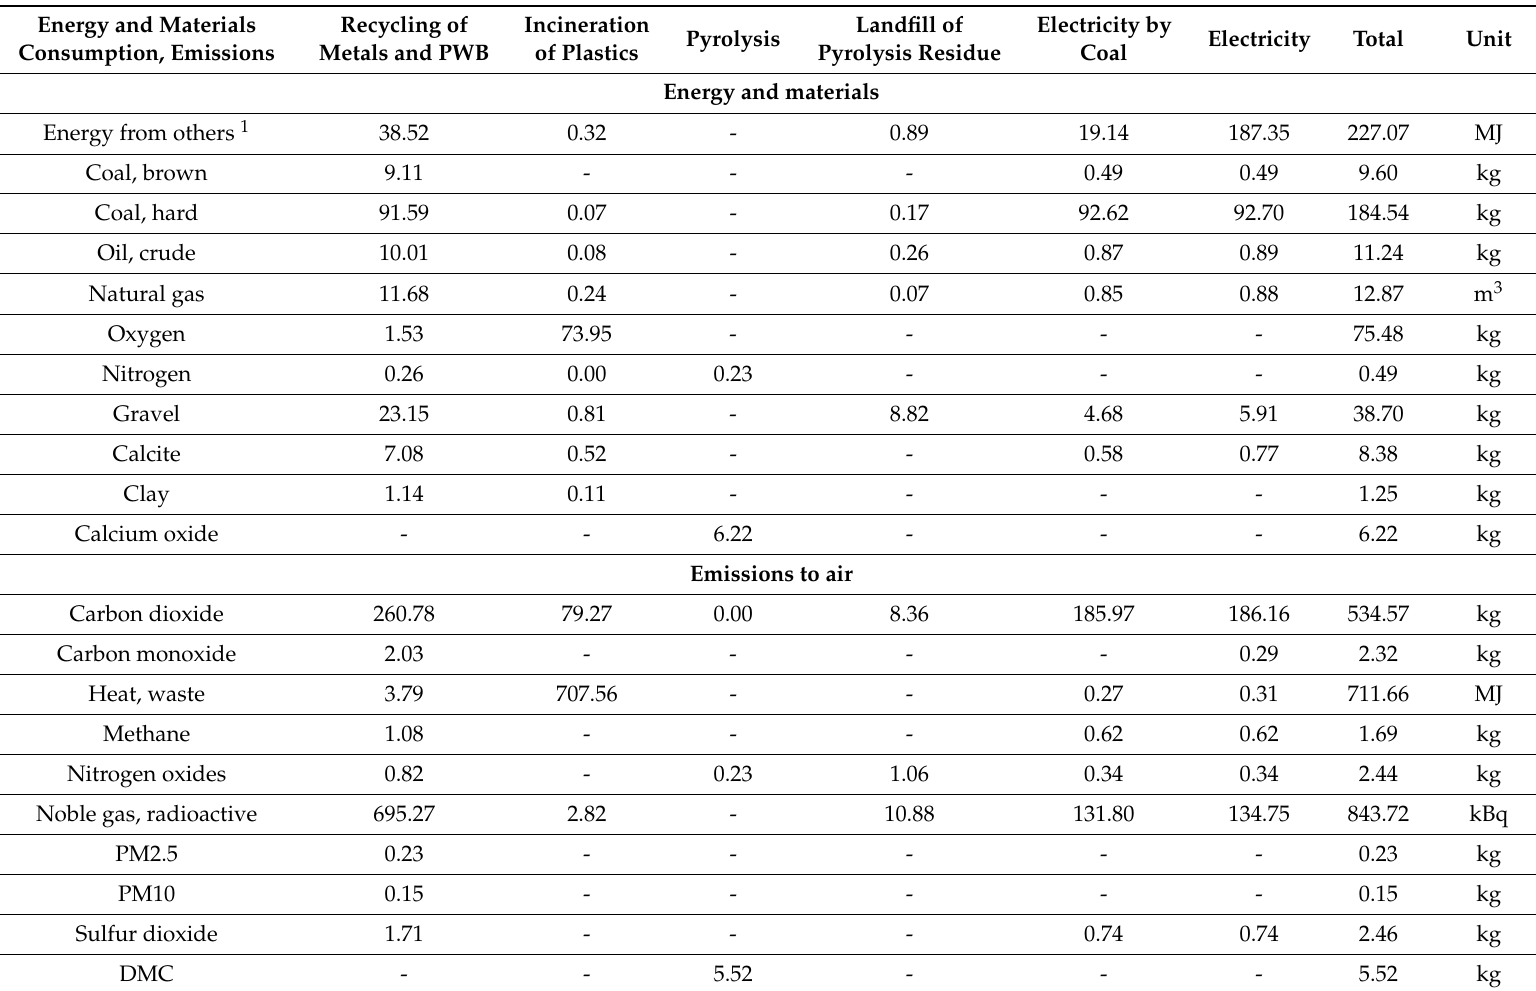
Table 5. The total life cycle inventory (LCI) during the disposal of a spent LiFePO 4 vehicle battery. Energy and Materials Consumption, Emissions